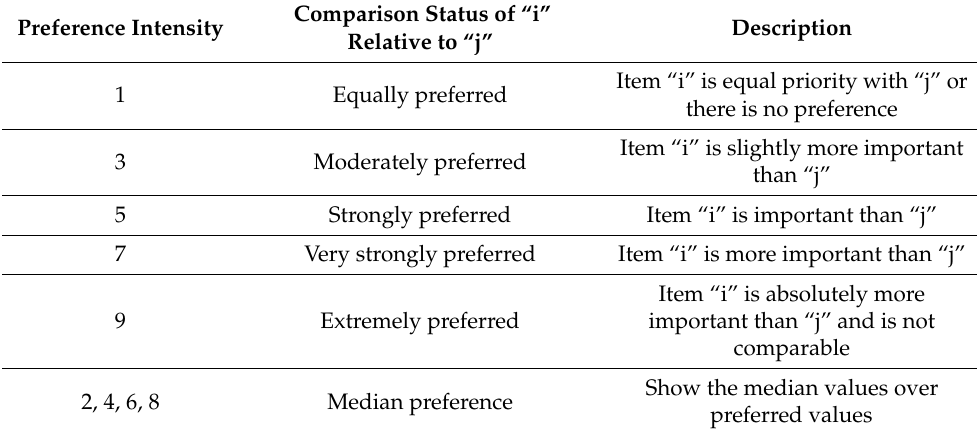
Table 1. Preference intensity evaluation by binary comparison relatively between criteria in AHP [58,59].